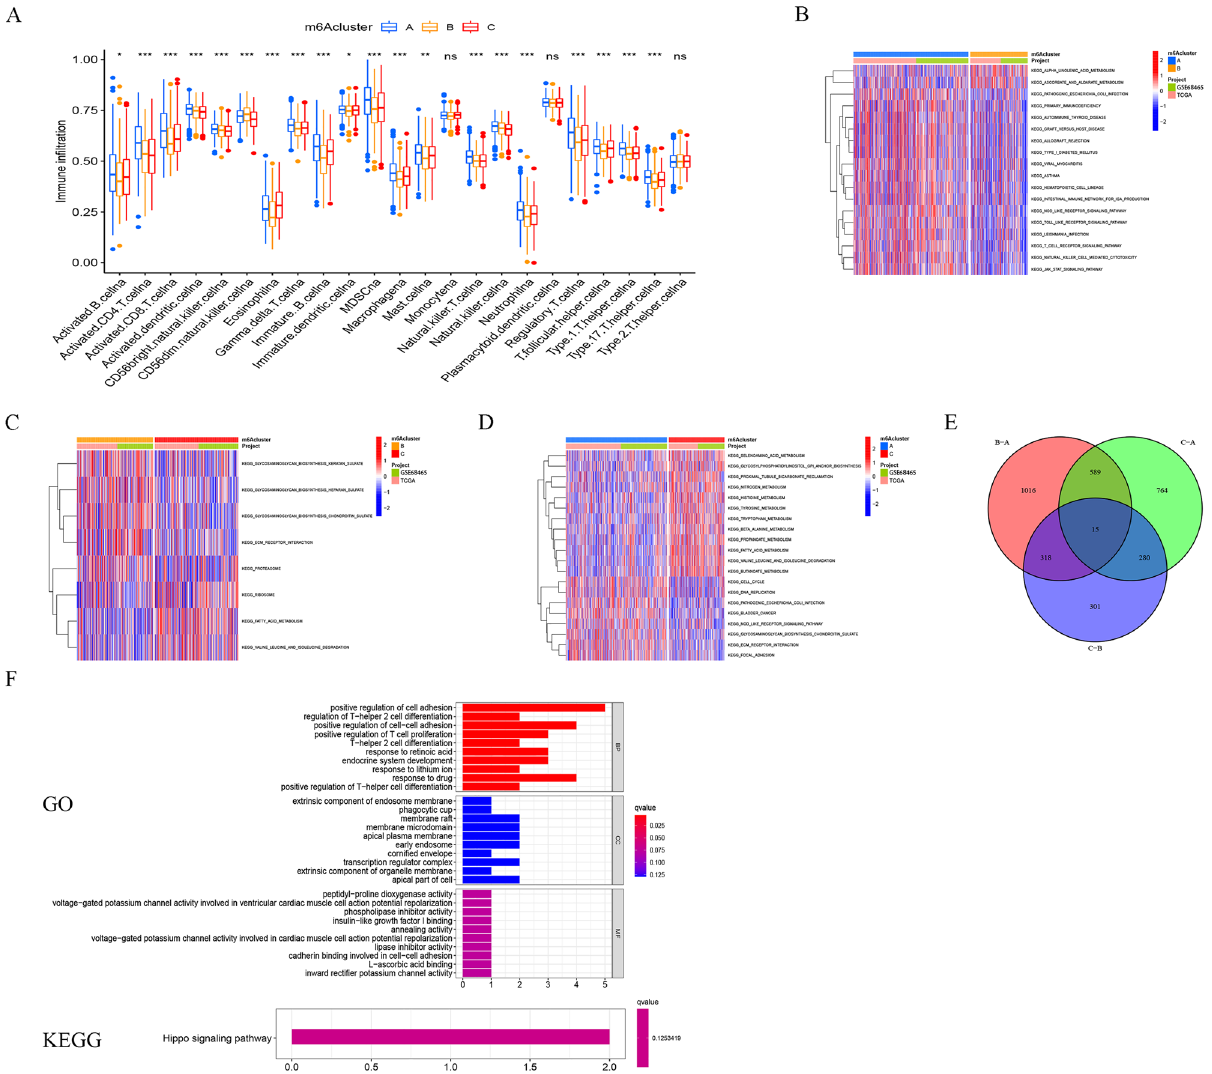
Figure 3. TME cell infiltration characteristics in distinct m 6 A modification patterns. ( A ) The abundance of TME infiltrating cell types in three m 6 A modification patterns. Statistical p-values are indicated by asterisks (* P < 0.05; ** P < 0.01; *** P < 0.001). ( B – D ) GSVA enrichment analysis showing the activation states of biological pathways in different m 6 A modification patterns. Heat map for the biological processes; red represents activated pathways and blue represents inhibited pathways. ( E ) Heat map showing overlapping genes for three m 6 A methylation modification pattern subtypes. ( F ) Results of GO (up) and KEGG (down)